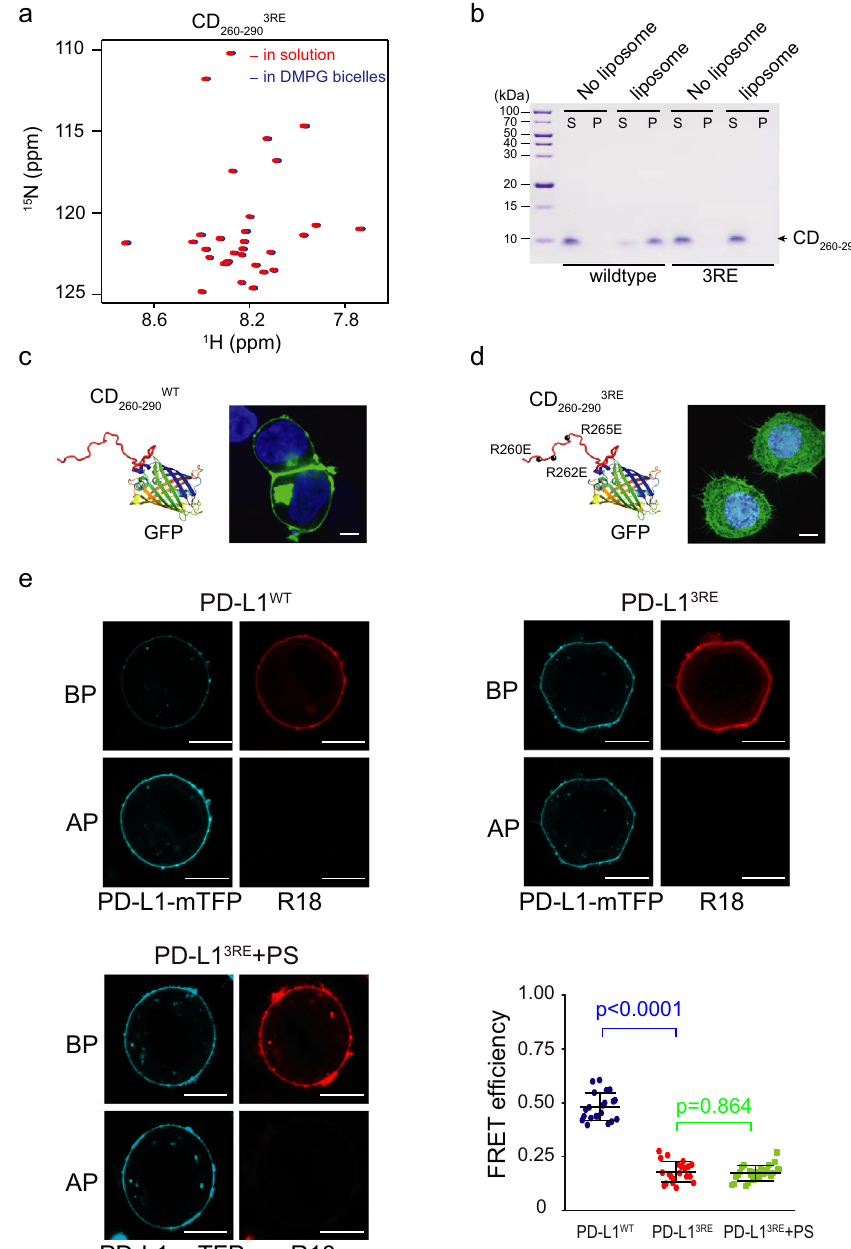
Fig. 3 Polybasic residues mediate the membrane interaction of PD-L1-CD in vitro and in cells. a Superimposed 2D 1 H- 15 N TROSY-HSQC spectra of CD 260-290 3RE mutant in solution (red) and with DMPG/DH 6 PC bicelles (blue). The spectra were recorded at 1 H frequency of 600 MHz using [ 15 N, 1 H]- labeled protein. b Wildtype and mutant CD 260-290 association with liposomes ( n = 3 independent experiments). The liposome binding assay was performed with (labeled as “ liposome ” ) or without liposomes (labeled as “ No liposome ” ) as in Fig. 1a but for CD 260-290 WT and CD 260-290 3RE mutant. The fractions after centrifugation were analyzed by SDS-PAGE, in which “ S ” represents the supernatant and “ P ” represents the pellet. c , d Localization of wildtype and mutant CD 260-290 in HEK293T cells. Confocal microscopy images of HEK293T cells expressing CD 260-290 WT -GFP ( c ) or CD 260-290 3RE ( d ) protein are shown. The experiment was repeated twice with similar results. Scale bars, 5 μ m. e Plasma membrane interaction of wildtype and mutant PD-L1 detected by FRET. The FRET ef fi ciency was determined for RKO cells expressing PD-L1 WT -mTFP (left top), PD-L1 3RE -mTFP (right top) and PD-L1 3RE -mTFP treated with 5 μ M PS (left bottom) for 2 h. Scale bars, 10 μ m. A similar whisker-dot plot shows the statistical results from n = 24, 22, or 25 WT or 3RE mutant-expressing cells, respectively (right bottom). Data are represented as mean ± SD. P values were determined by unpaired two-sided Student ’ s t-test. Source data are provided as a Source Data fi